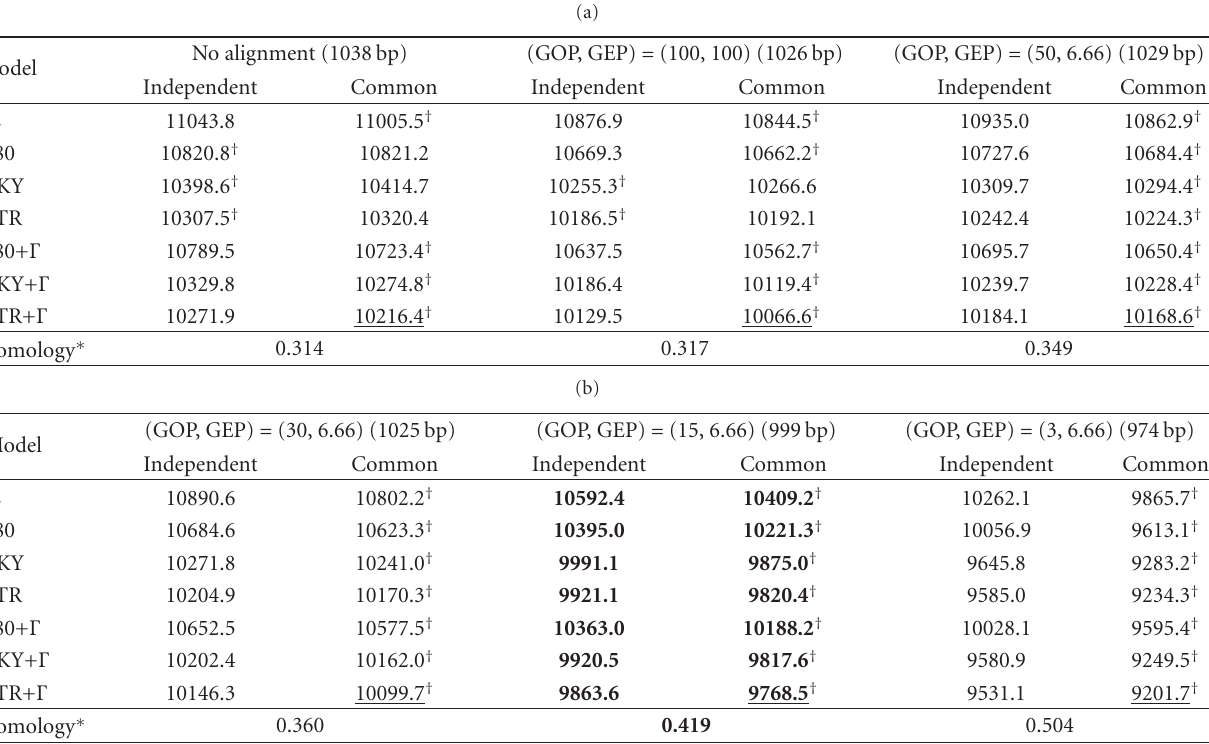
Table 1: Formal tests of the common ancestry between cytb and nd2 based on the nucleotide sequence data sets aligned with various values of gap penalties (GOP and GEP).